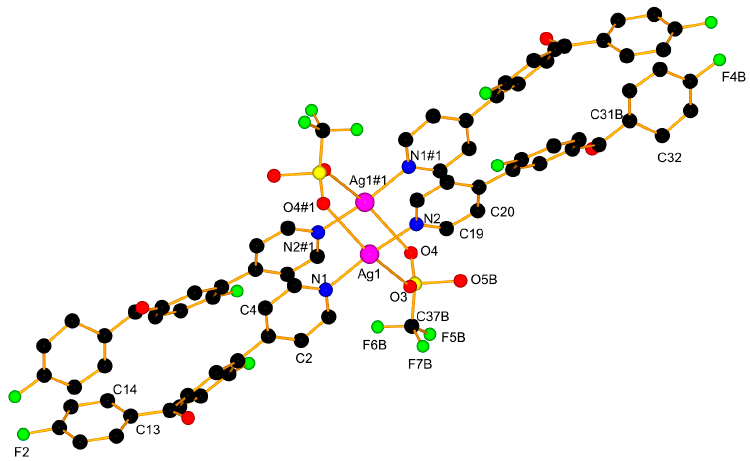
7 of 16 Figure 2. View of the molecular structure of 3 in ellipsoid 50% probability. Figure 3. View of the molecular structure of 4 in ellipsoid 50% probability.